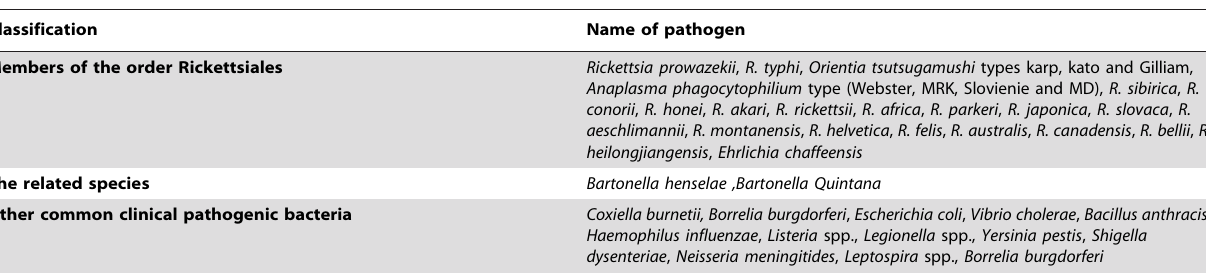
Table 1. Laboratory strains for determining the specificity of the LAMP assay.